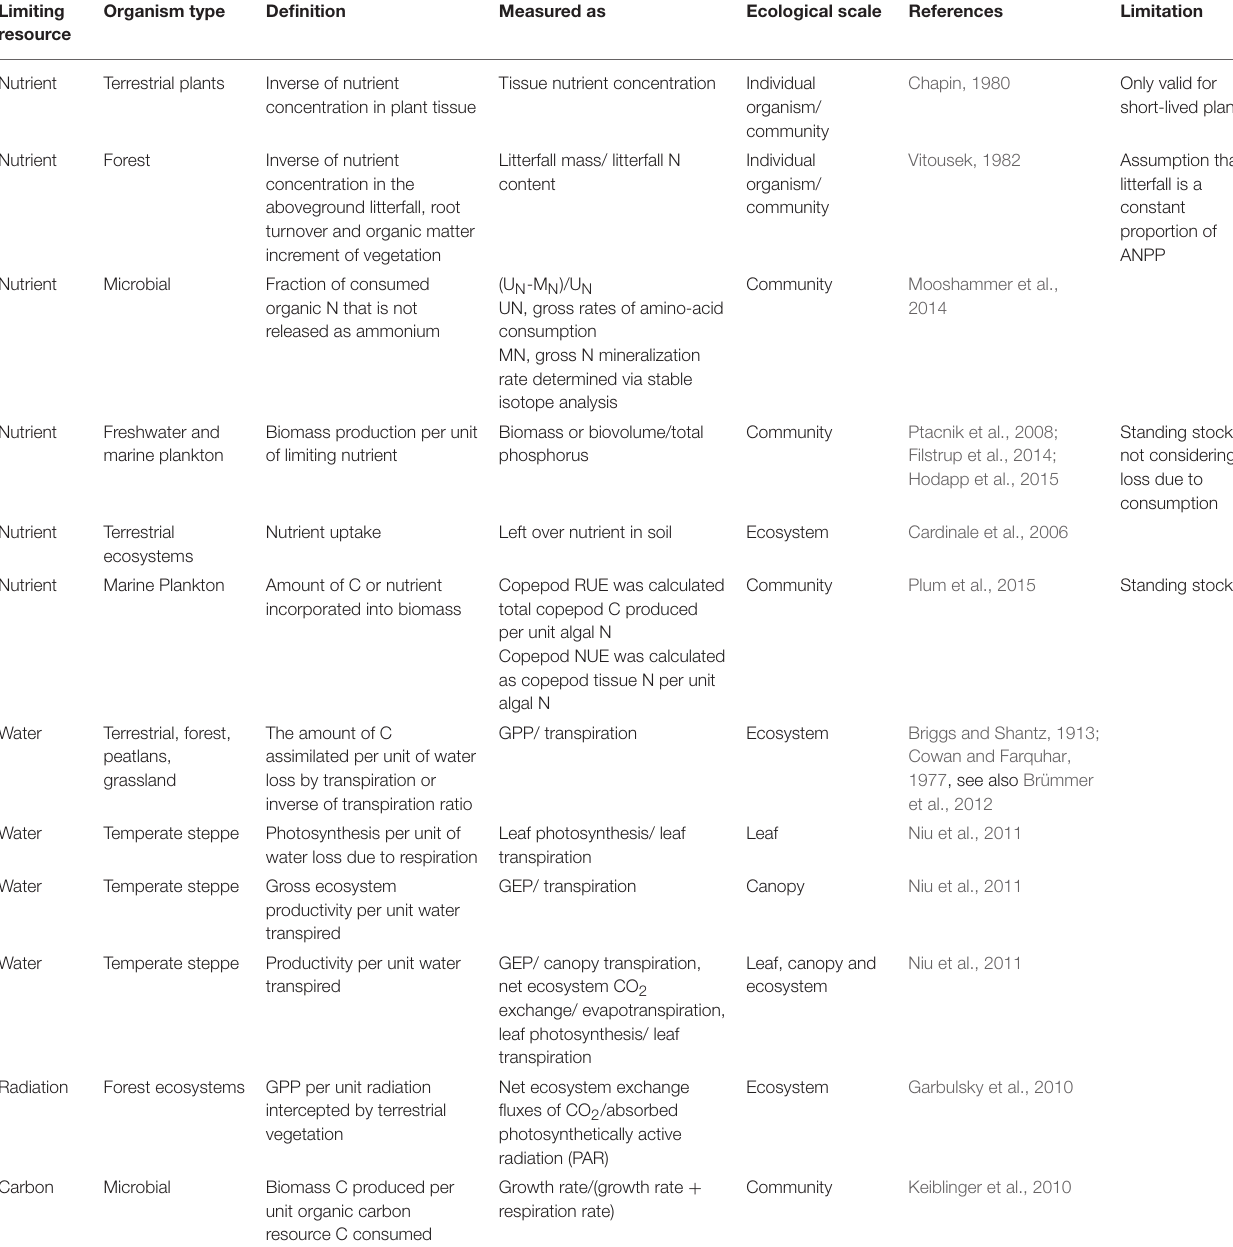
TABLE 1 | Examples for definitions and uses of resource use efficiency for different organism types along different ecological scales. Limiting